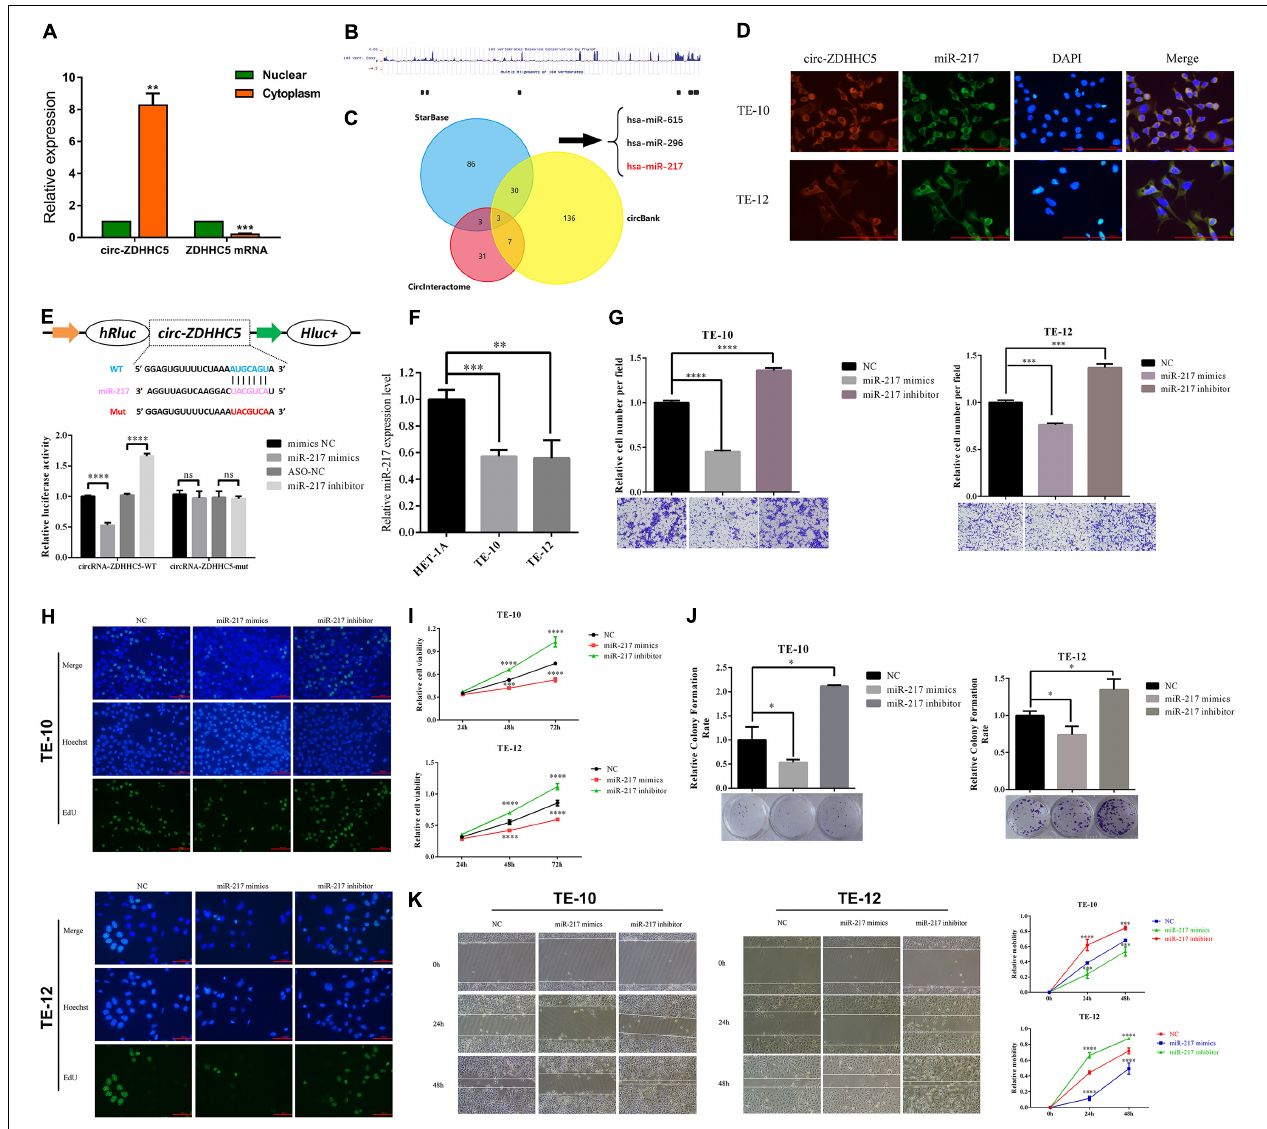
FIGURE 3 | Circ-ZDHHC5 directly binds to miR-217 and inhibits miR-217 activity. (A) The nucleus-cytoplasm fractionation experiment showed the location of circ-ZDHHC5. (B) circ-ZDHHC5 was predicted to have binding sites for AGO2. (C) circ-ZDHHC5 might become a sponge for multiple miRNAs. (D) FISH showed the co-location of circ-ZDHHC5 and miR-217. (E) The schematic of circ-ZDHHC5 wild-type (WT) and mutant (Mut) luciferase reporter vectors. The relative luciferase activities were explored in 293T cells co-transfected with miR-217 mimics or miR-NC and luciferase reporter vectors circ-ZDHHC5-WT or circ-ZDHHC5-Mut. (F) The expressions of miR-217 were explored with qRT-qPCR in ESCC cells. (G) Cell invasion experiments were performed in cells transfected with miR-217 mimics or inhibitors with a Transwell chamber. (H–J) EdU, CCK-8, and colony formation experiments of ESCC cells transfected with miR-217 mimics or inhibitors were performed for the assessment of cell proliferation. (K) Cell motility was determined in cells transfected with miR-217 mimics or inhibitors by the wound healing experiment. (* p < 0.05, *** p < 0.001, **** p < 0.0001).